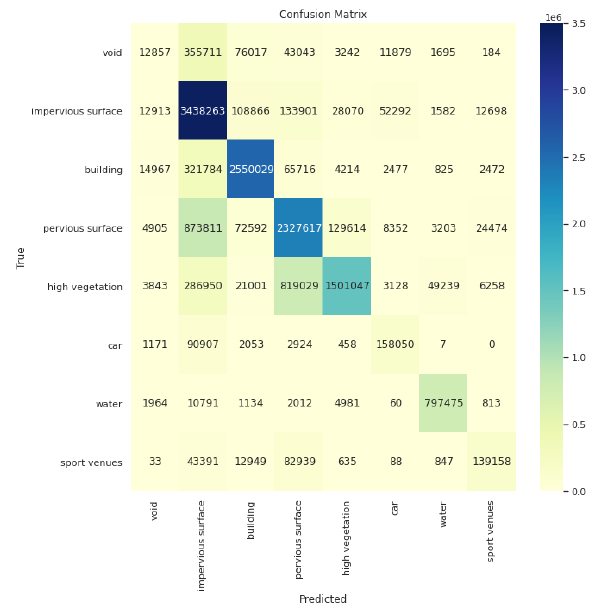
Figure 10. Confusion matrix of the baseline network.